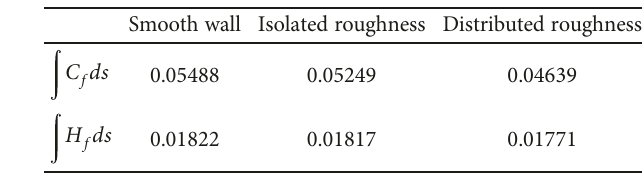
Table 2: Integral value of friction coe ffi cient and heat fl ux along the